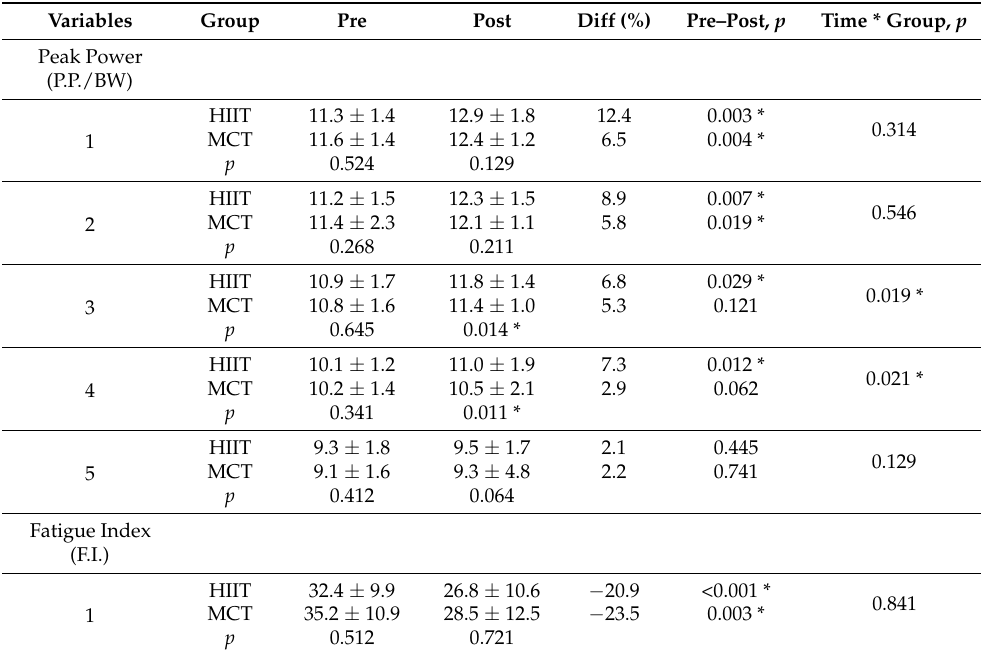
Table 5. Anaerobic power testing with the Wingate ergometer